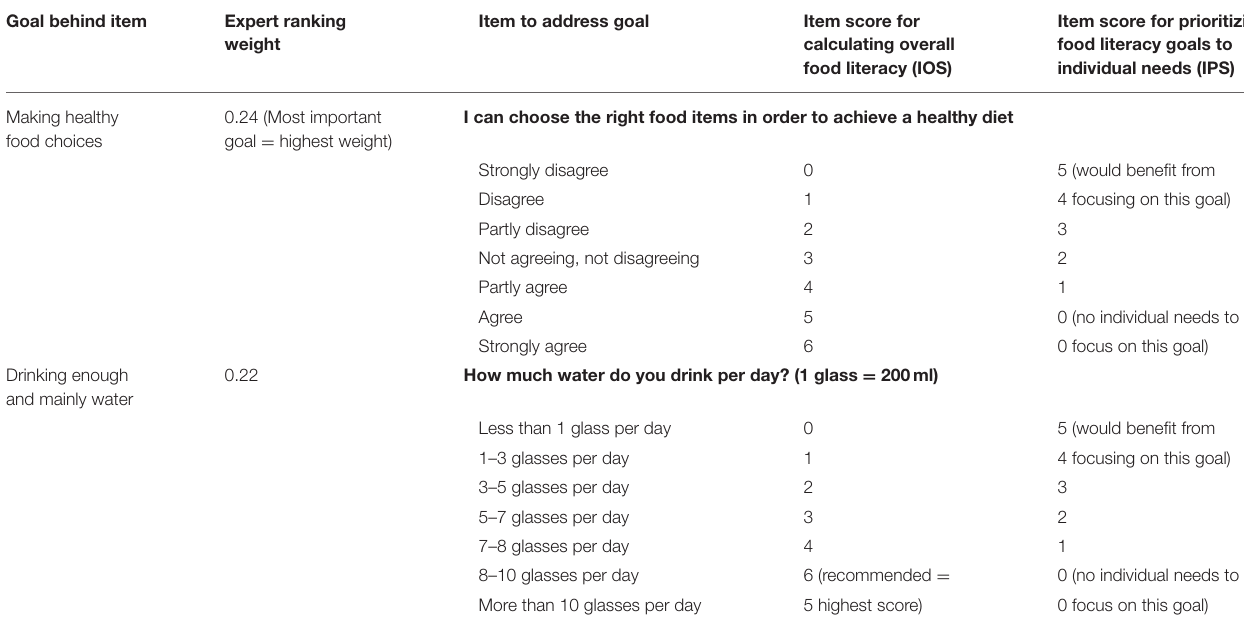
TABLE 2 | Example of scoring and prioritizing process.